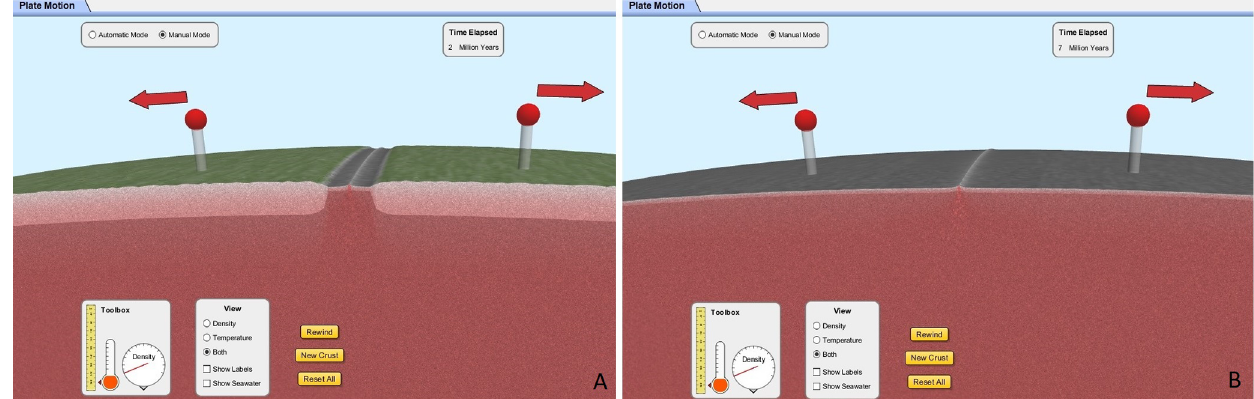
Figure 7. A rift can be formed through the divergence of the continental crust (a) but also through the divergence of old oceanic crust (b) . Caption from PhET™ Plate Tectonics.